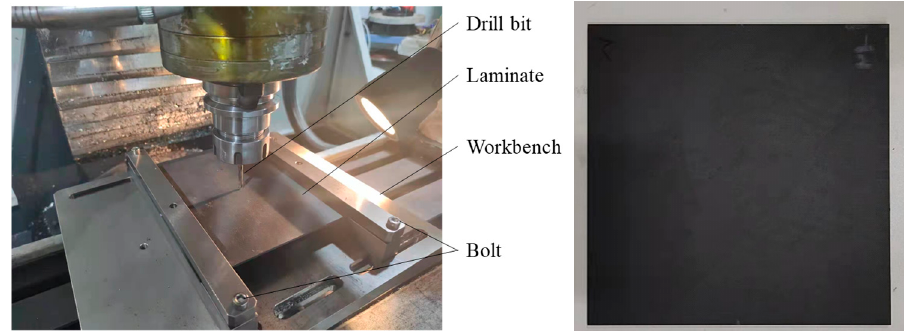
Figure 3. Test Equipment and sample.